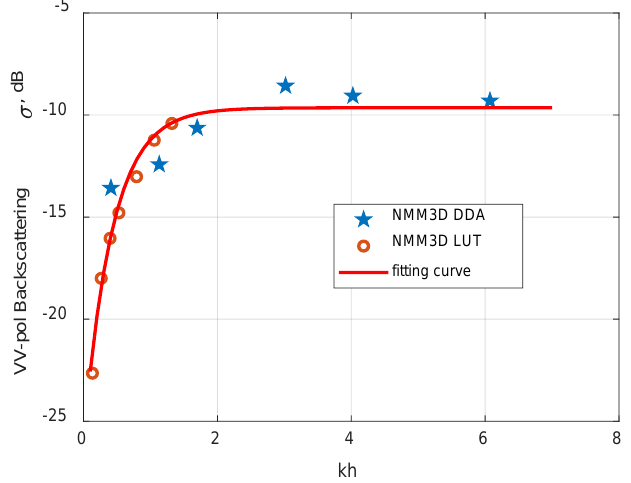
backscattering direction increase with the roughness and then finally reaches a maximum value (which is corresponding to the geometric optics (GO) realm [39]). Saturation was also postulated by Oh’s empirical model without experimental data in the large kh regime [59].